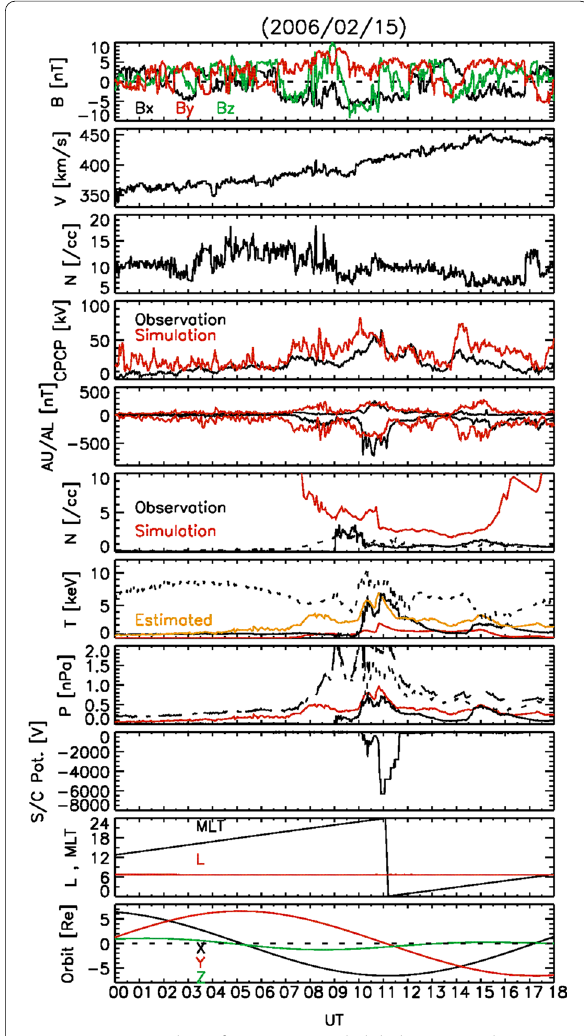
Fig. 3 Time series data of LANL/MPA and global MHD simulation for a deep surface charging event during an isolated substorm that occurred at around 10:00 UT on February 15, 2006. The top three panels show the OMNI data: the three components of IMF (in the GSM coordinate system), solar wind speed, and solar wind density. The fourth and fifth panels show the cross polar cap potential (CPCP) estimated from the PCN index (Troshichev et al. 1996) and AU/AL indices (simulation data are shown by red lines). The sixth to eighth panels, respectively, show N e , N i , and simulated plasma density N sim ; T e , T i , and simulated plasma temperature T sim ; and P e , P i , and simulated plasma pressure P sim . (The observed electron, ion, and simulation data are shown by the solid black, dotted black, and solid red lines, respectively.) The ninth panel shows the satellite potential. The bottom two panels show the satellite orbit in (MLT, L) and in ( X , Y , Z ) of the GSM coordinate system, respectively. The orange line in the seventh panel shows the estimated electron temperature T